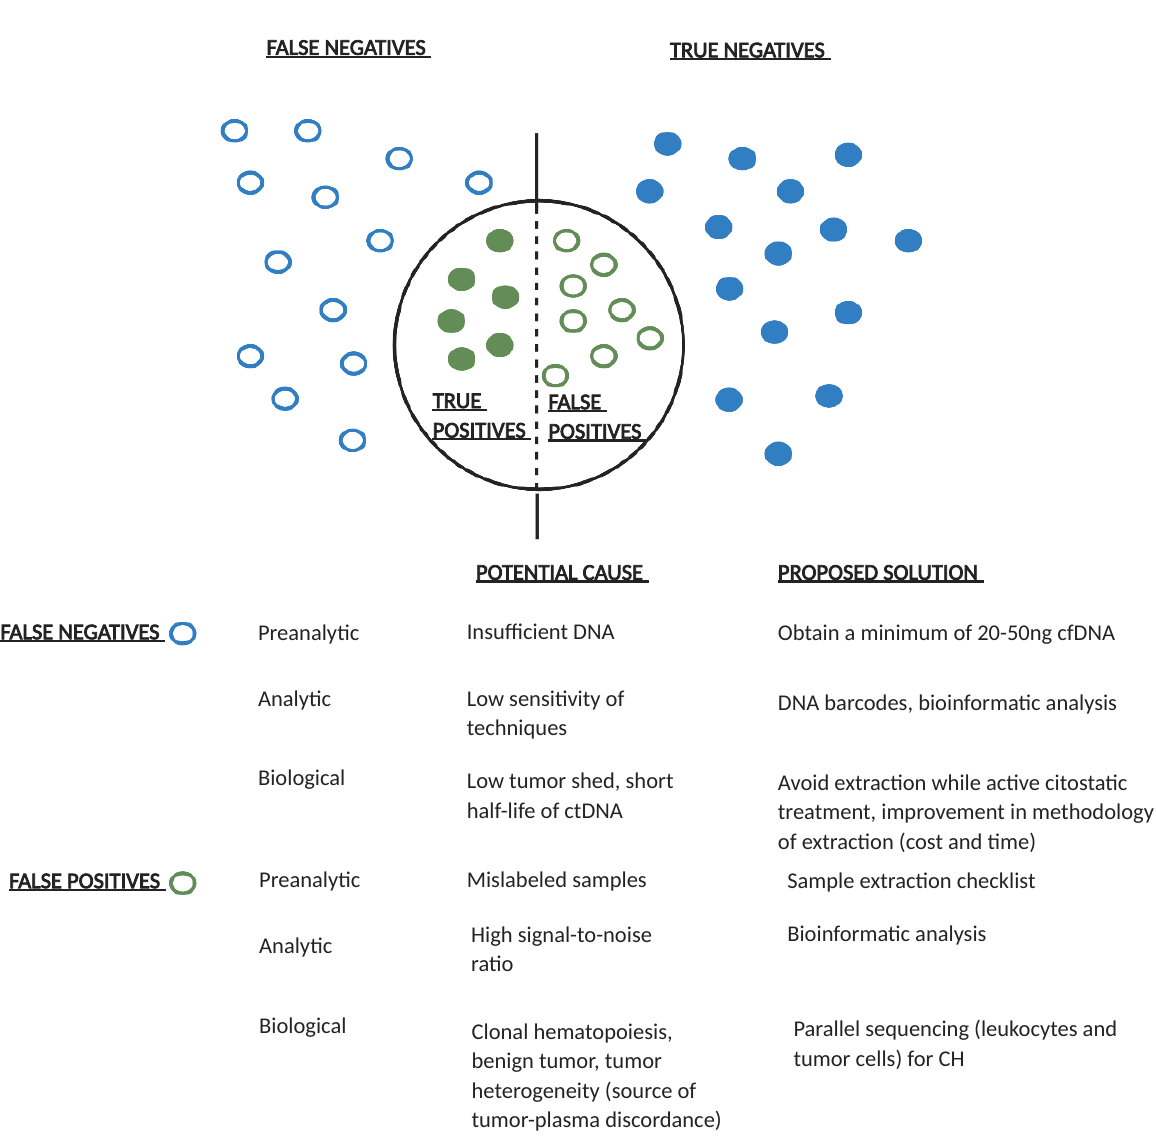
Figure 4. Potential causes of false positive and false negative results in ctDNA analysis and proposed solutions. Empty dots represent false positive/negative results and filled dots represent true positive/negative ctDNA results. For each pre- analytical, analytical, or biological potential false positive/negative result, a possible solution is proposed. Ng: nanograms; cfDNA: cell free DNA; CH: clonal